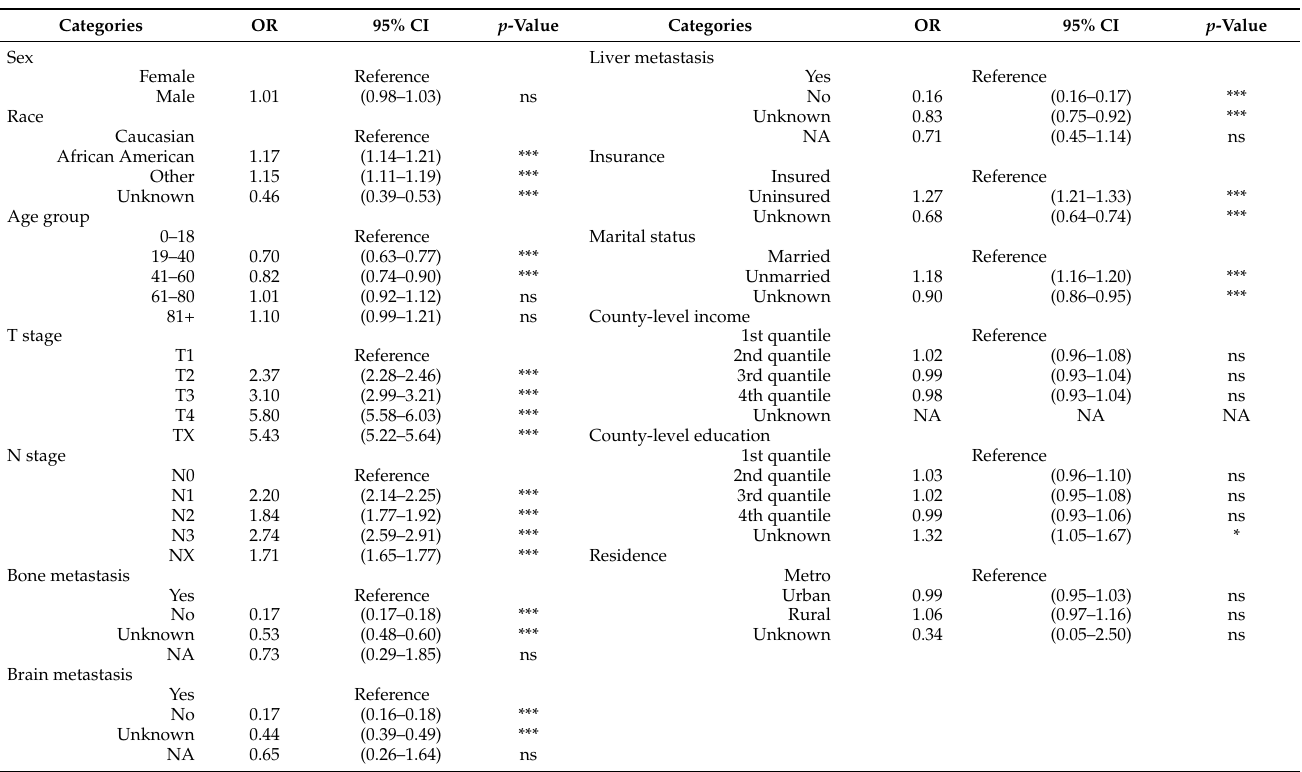
Table 3. Multivariate logistic regression of occurrence of synchronous lung metastasis adjusted by primary cancer